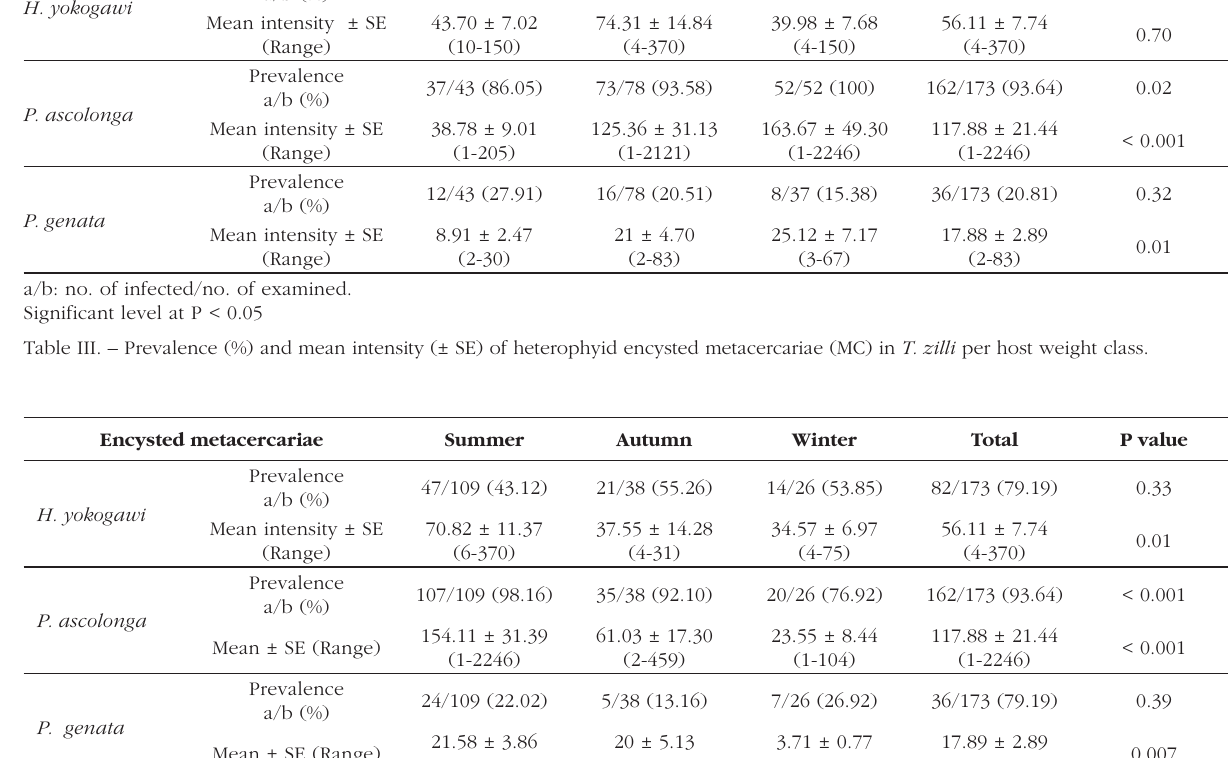
Table IV. – Seasonal prevalence and mean intensity of heterophyid encysted metacercariae (MC) in T. zilli